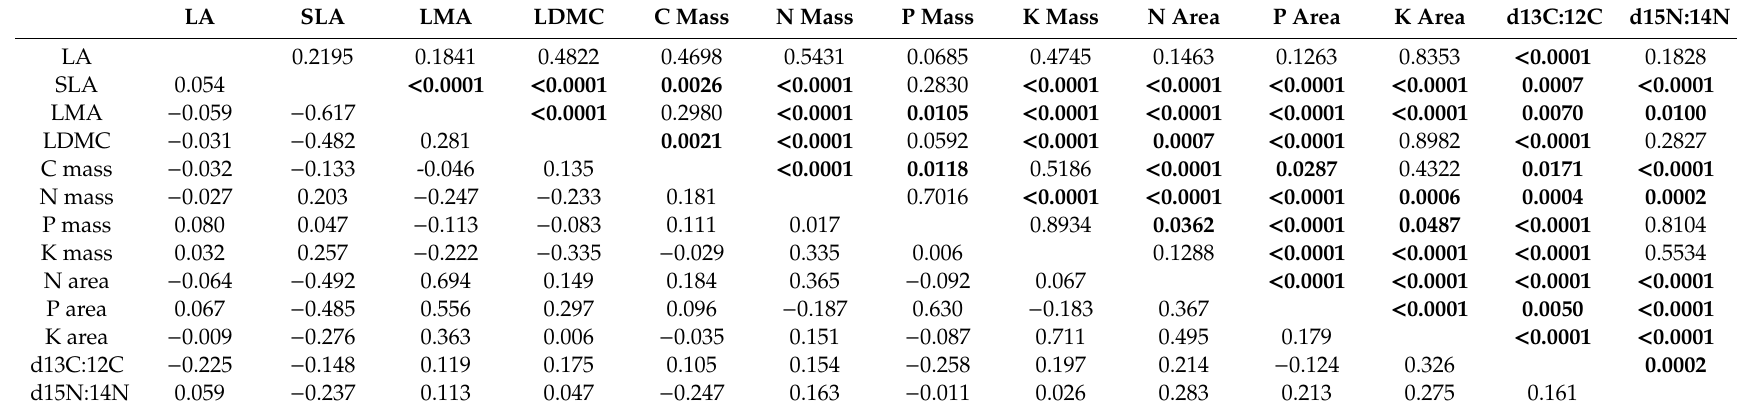
Table 2. Pearson correlations e ffi cient and correlation significance level between functional traits across China’s di ff erent climates and